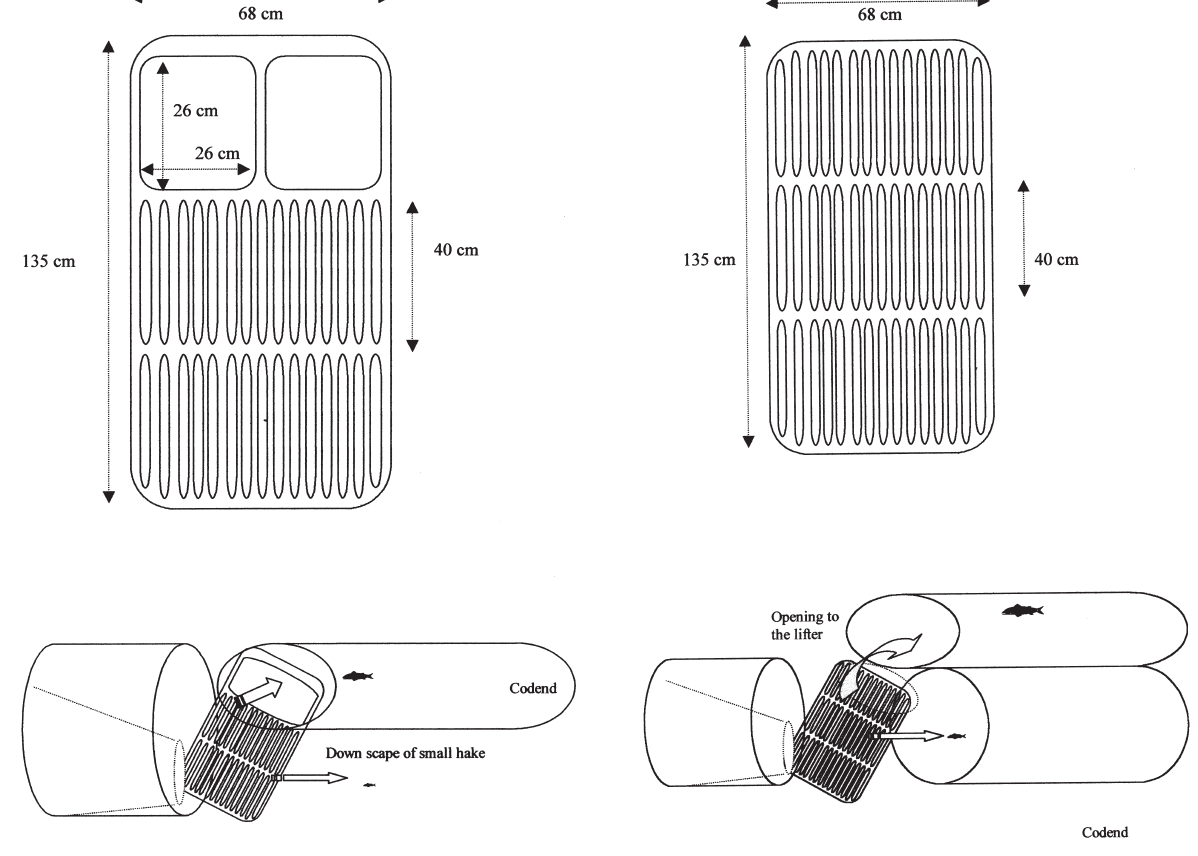
F IG . 1. – Scheme of grid A (20 mm bar separation). Big fishes are diverted to codend (Fig. 5A).